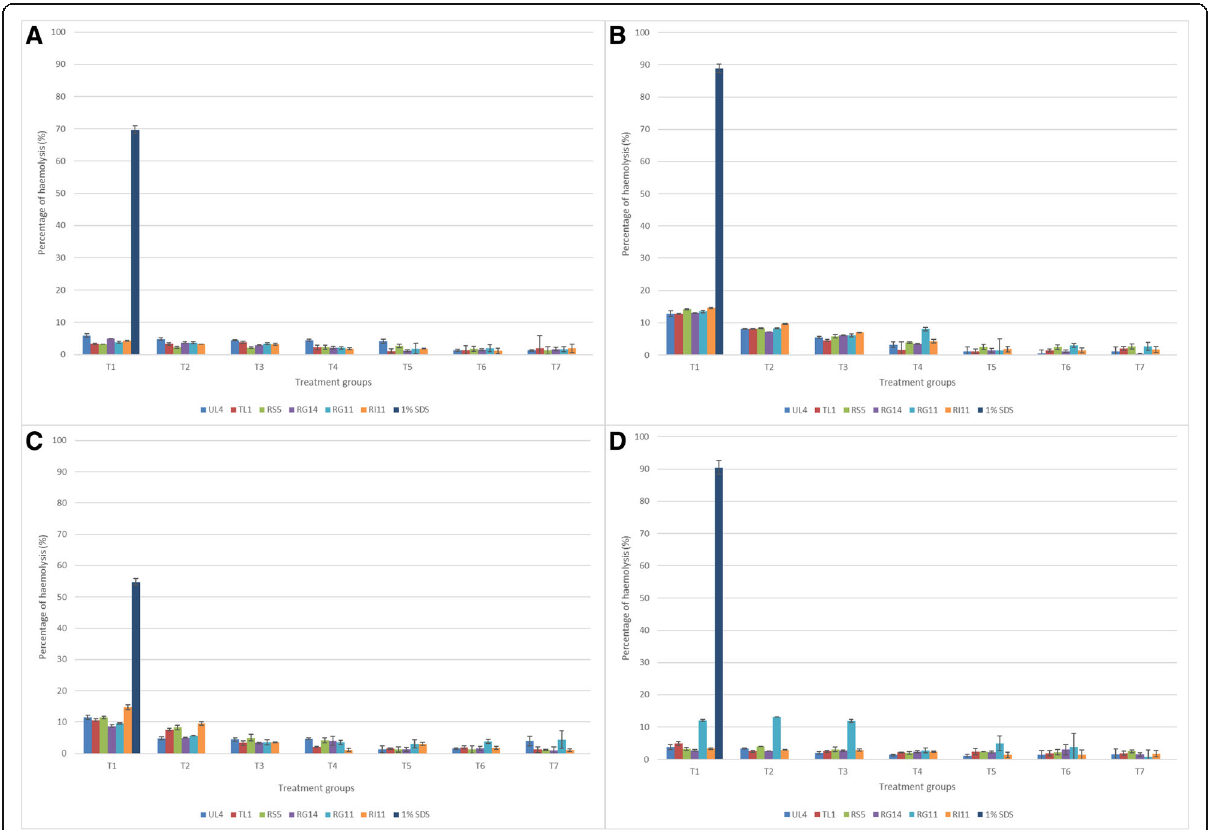
Fig. 1 Haemolysis effect of PM produced by six stains of Lactobacillus plantarum on ( a ) human, ( b ) rabbit, ( c ) chicken and ( d ) dog RBC. T1: 100% (v/v); T2: 50% (v/v): T3: 25% (v/v); T4: 12.5% (v/v); T5: 6.25% (v/v); T6: 3.13% (v/v); T7: 1.56% (v/v); 1% SDS: 1% (w/v) SDS. Each bar represents the mean ± SEM of nine